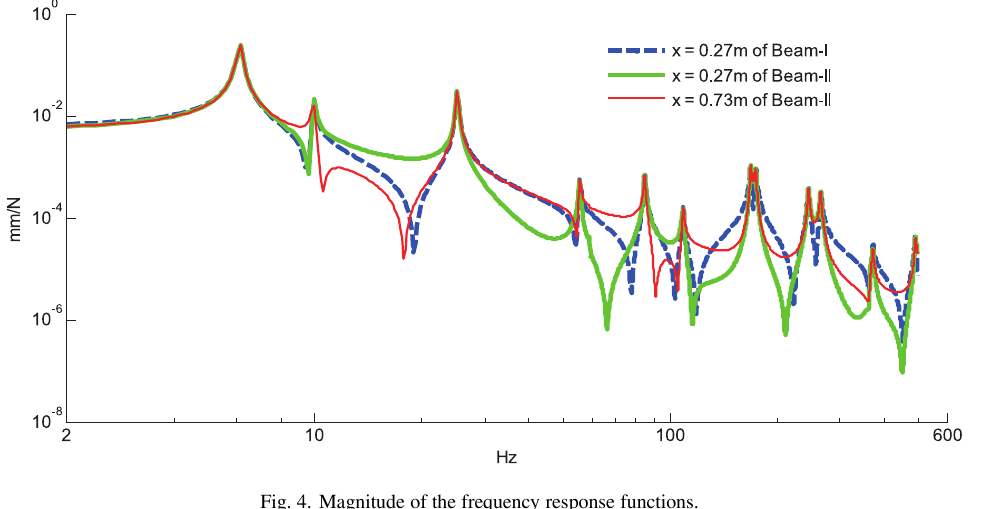
Fig. 4. Magnitude of the frequency response functions.